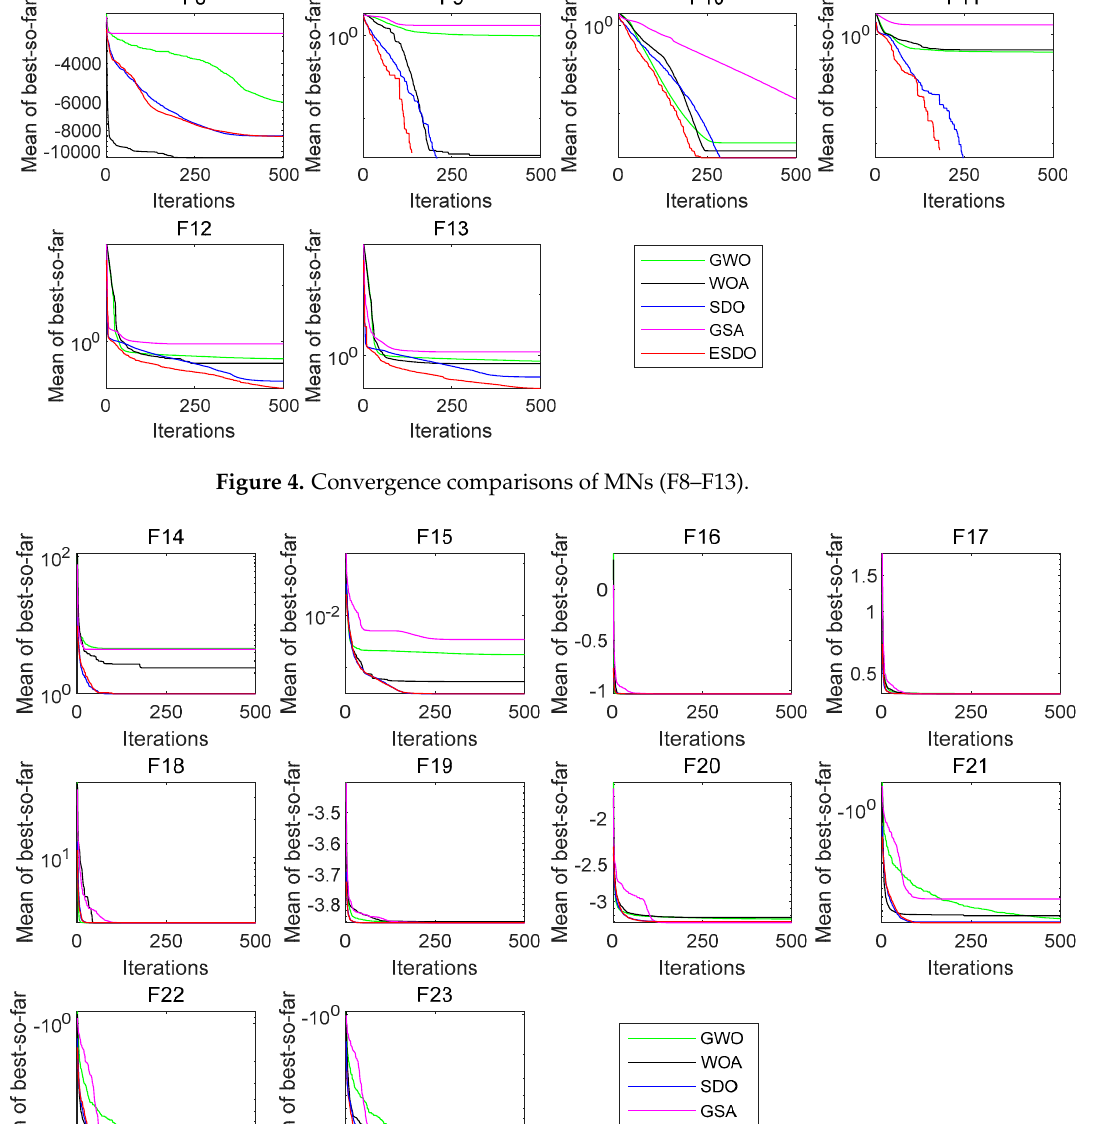
10 of 24 Table 4. Comparison results of LMNs (F14–F23). NO. Index